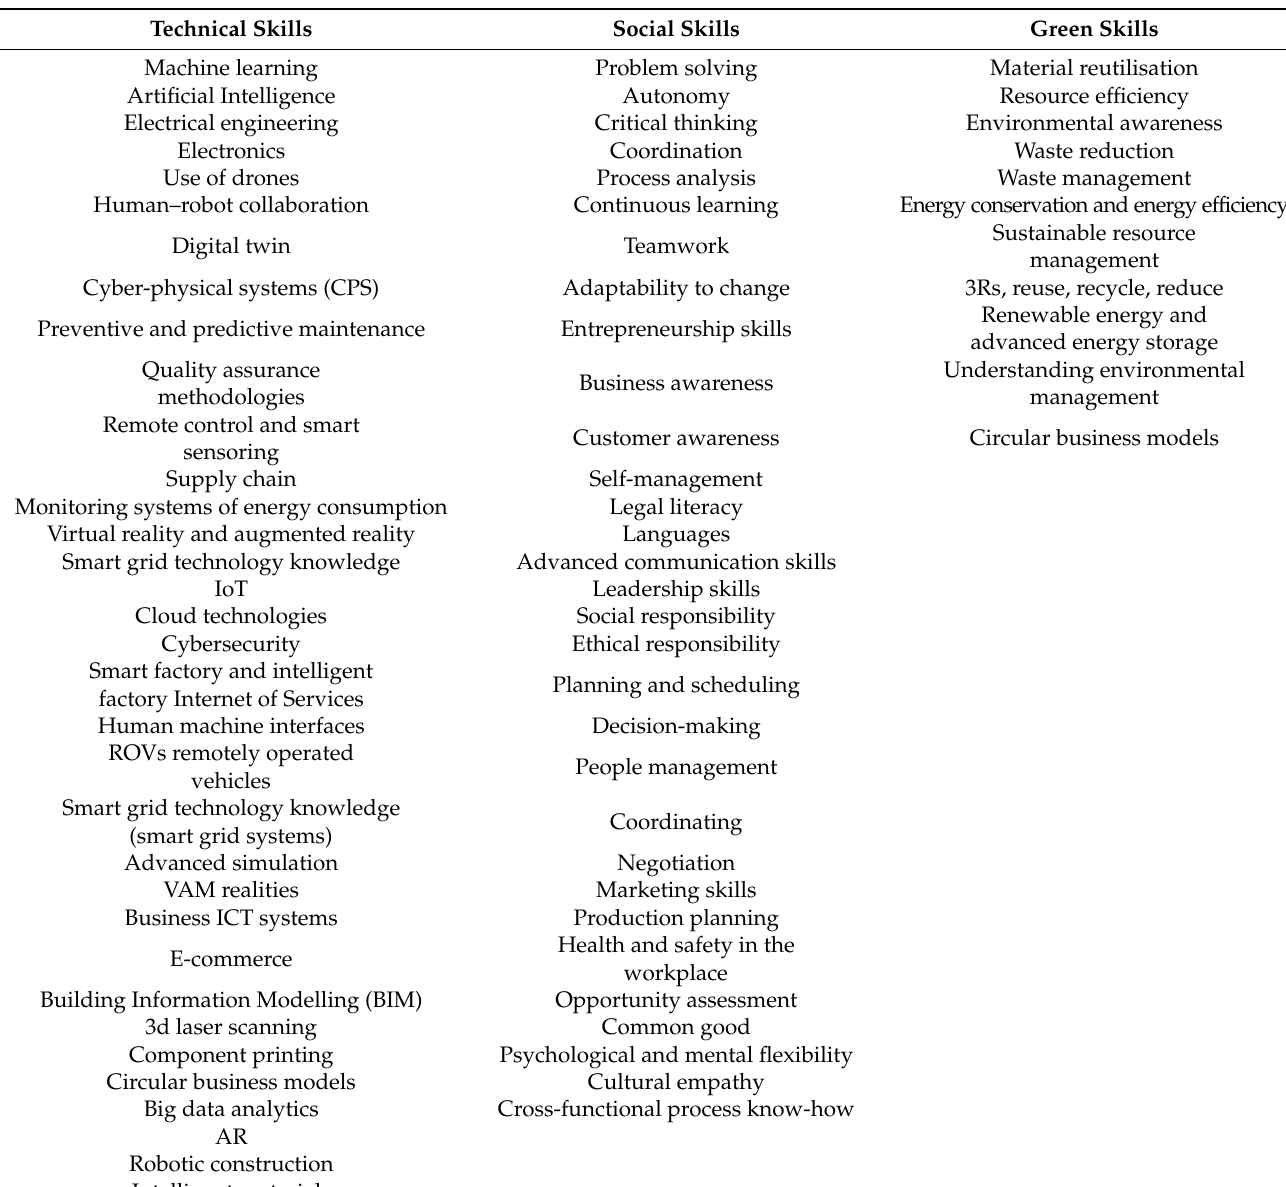
Table 5. List of the identified future skills for the manufacturing